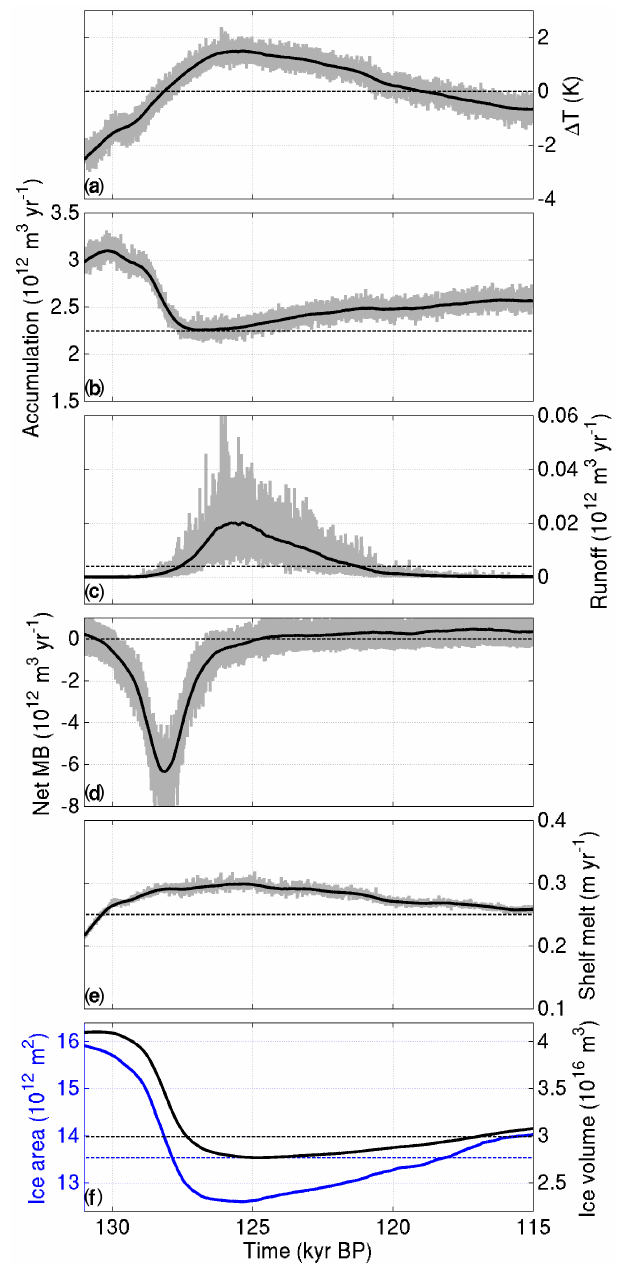
Figure 8. Antarctic ice sheet forcing and characteristics. Temper- ature anomaly relative to the pre-industrial period (a) , accumula- tion (b) , surface meltwater runoff (c) and net mass balance of the grounded ice sheet (d) , and average sub-shelf melt rate diagnosed for the area of the present-day observed ice shelves (e) . Mass bal- ance terms ( b – e ) are given in water equivalent. (f) Grounded ice sheet area (blue) and volume (black). Grey lines give full annual time resolution, while black lines (and blue in f ) are smoothed with a 400-year running mean. Horizontal dashed lines give the pre- industrial reference values, except for (d) , where it is the zero line.